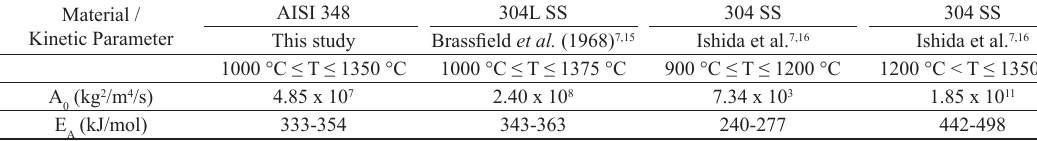
Table 3. Kinetic parameters of Zircaloy models. Material / Kinetic Parameter